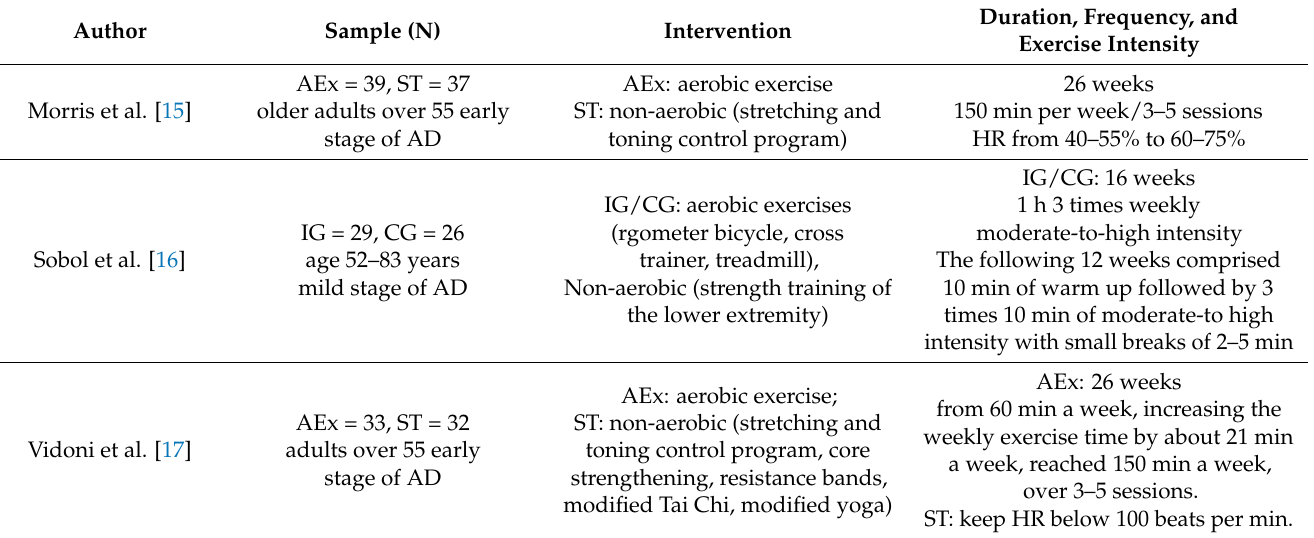
Table 1. Characteristics of the studies included in the